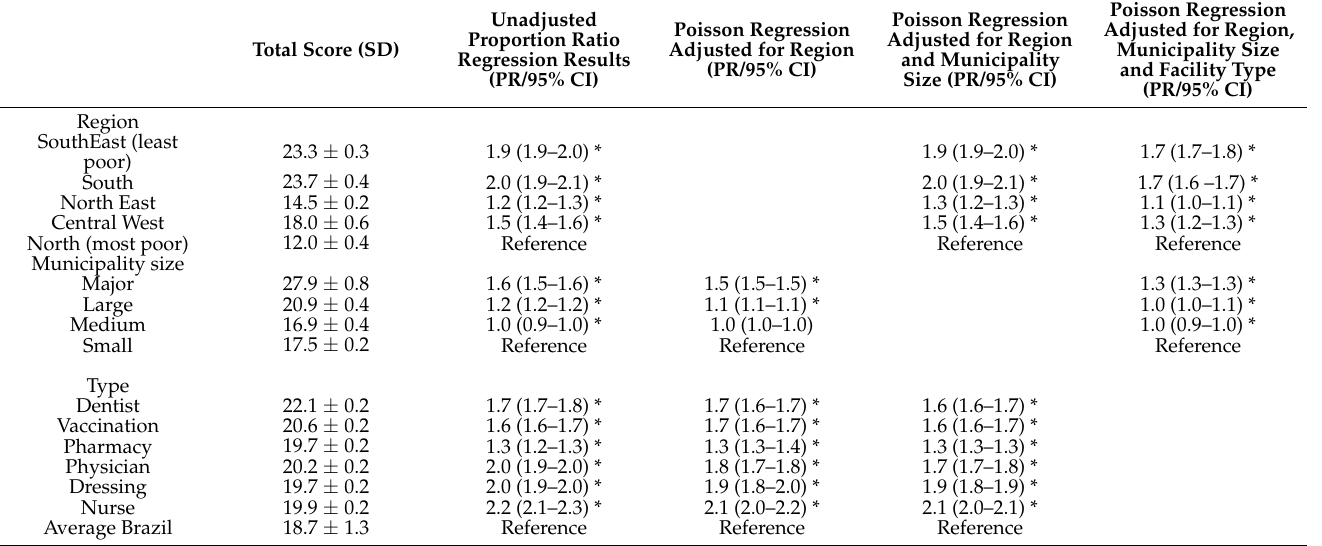
Table 6. Poisson regression estimates of the association of total accessibility score with Region, Municipality size and facility type.